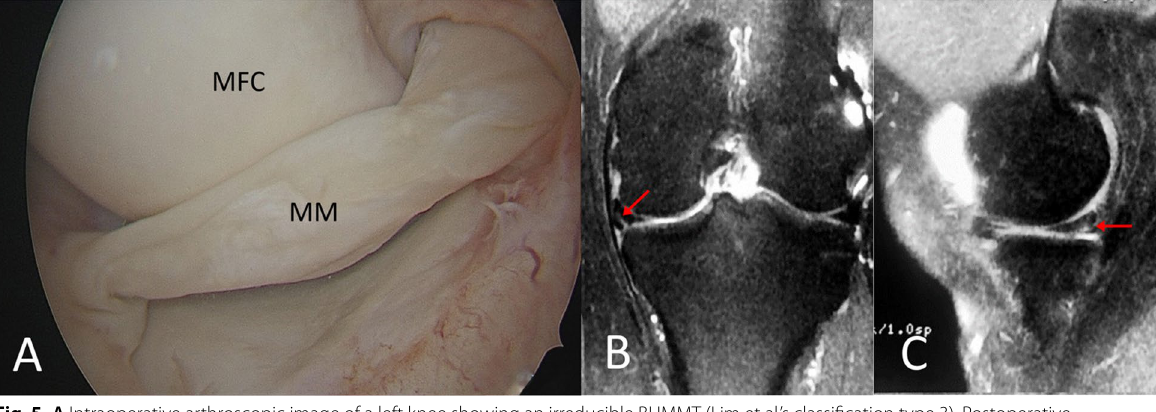
Fig. 5 A Intraoperative arthroscopic image of a left knee showing an irreducible BHMMT (Lim et al.’s classification type 3). Postoperative T2-sequenced coronal ( B ) and sagittal ( C ) MRI shows an unhealed repair ( red arrow ) after 6 months. MRI magnetic resonance imaging, MM medial meniscus, MFC medial femoral